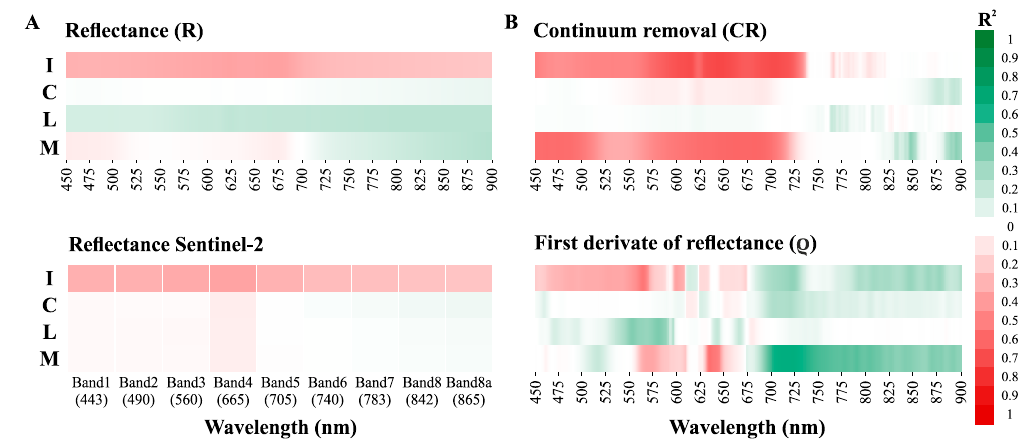
Figure 6. Comparing the coefficient of determination (R 2 ) between reflectance (R), continuum removal (CR), and first derivate of reflectance ( ρ ) and chlorophyll a concentration for all the studied communities calculated with the hyperspectral ( A ) and Sentinel-2 resampled ( B ) data. I: incipient, C: cyanobacteria-dominated, L: lichen-dominated, and M: moss-dominated. Green scale values of the coefficient of determination indicate a positive relationship between response variable (Chl a ) and predictor factor (spectral information), whereas red scale values indicate a negative relationship.